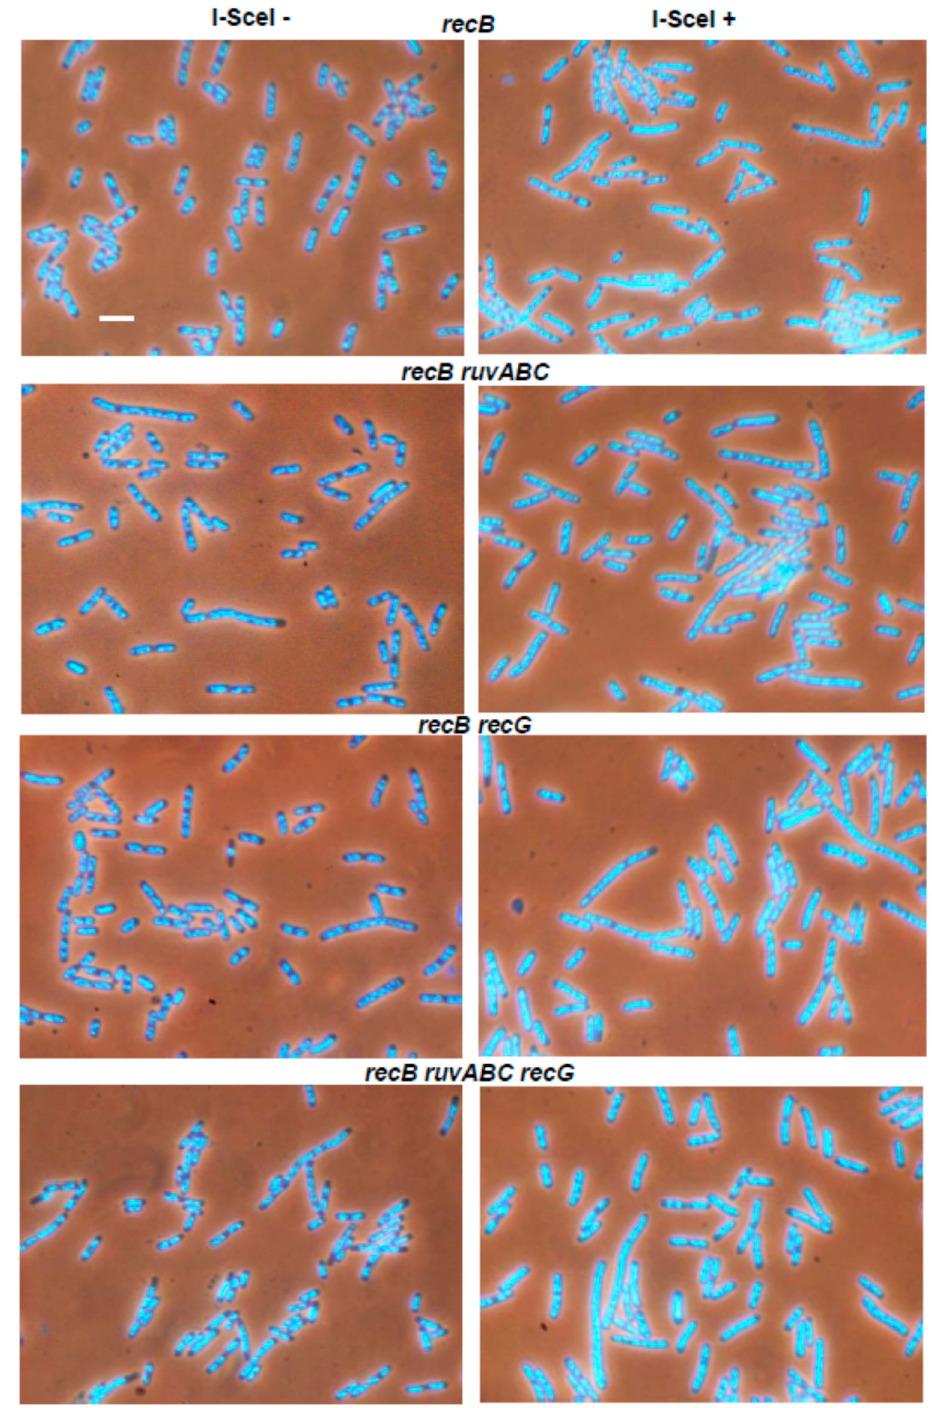
Figure 2. The recB mutation suppresses I- Sce I-induced cytological defects in ruvABC and/or recG mutants. Bar, 5 μ m.